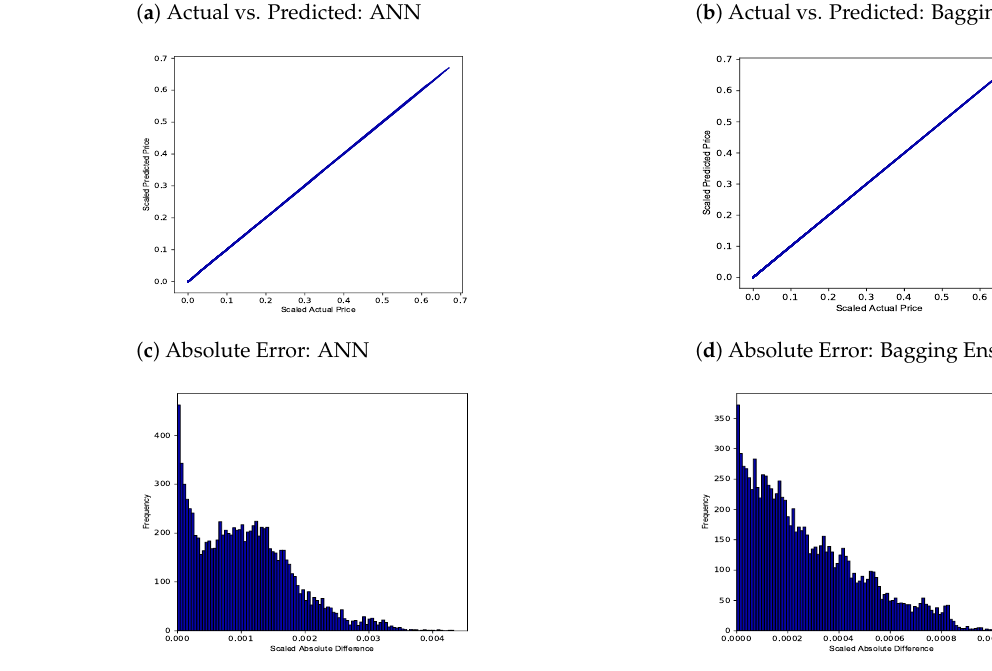
Figure 5. Actual vs. predicted results: zero